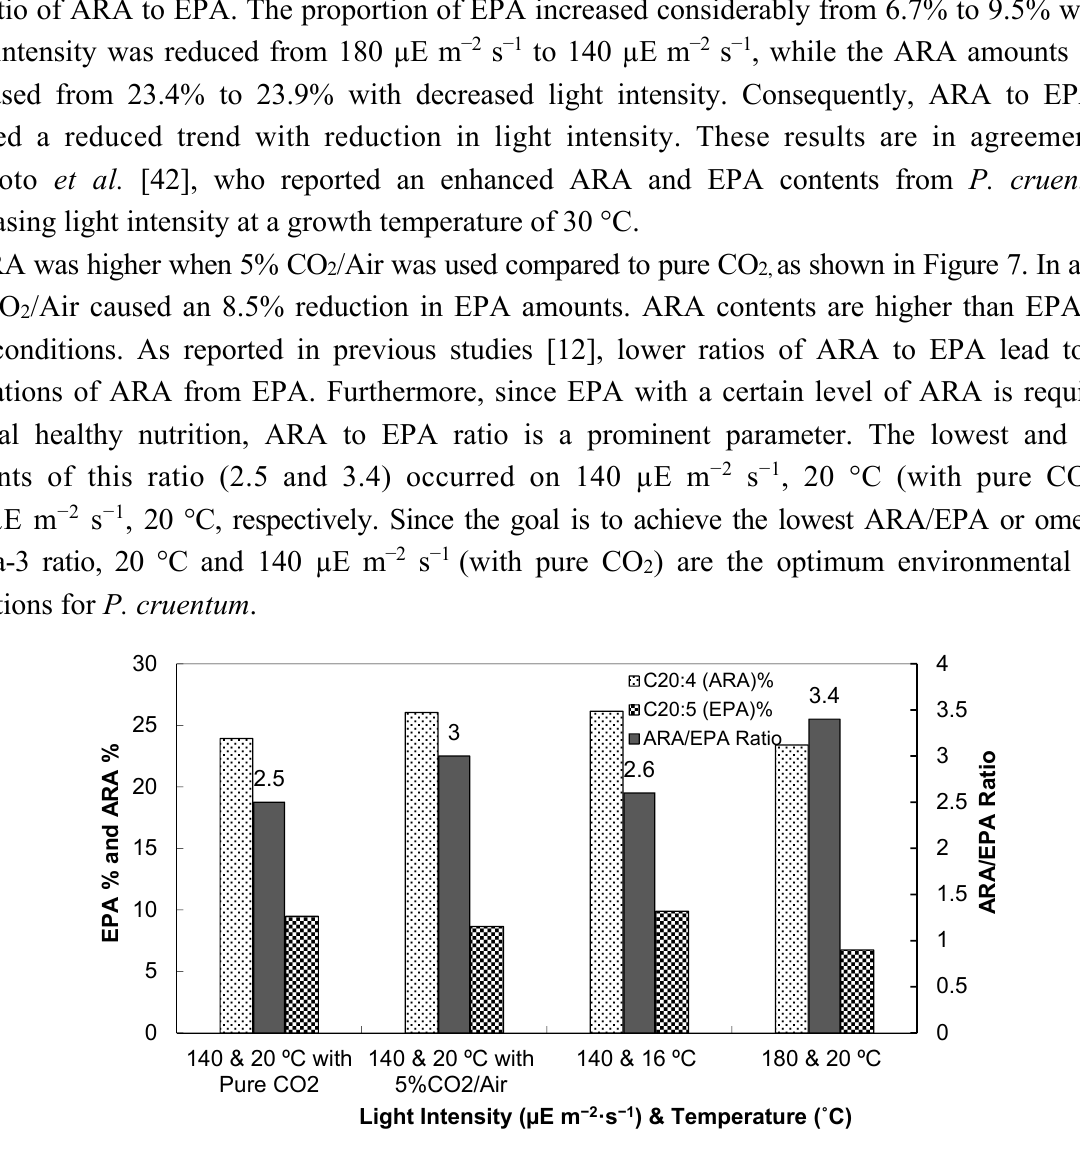
Figure 7. Effect of illumination and temperature on the EPA and ARA contents of P. cruentum